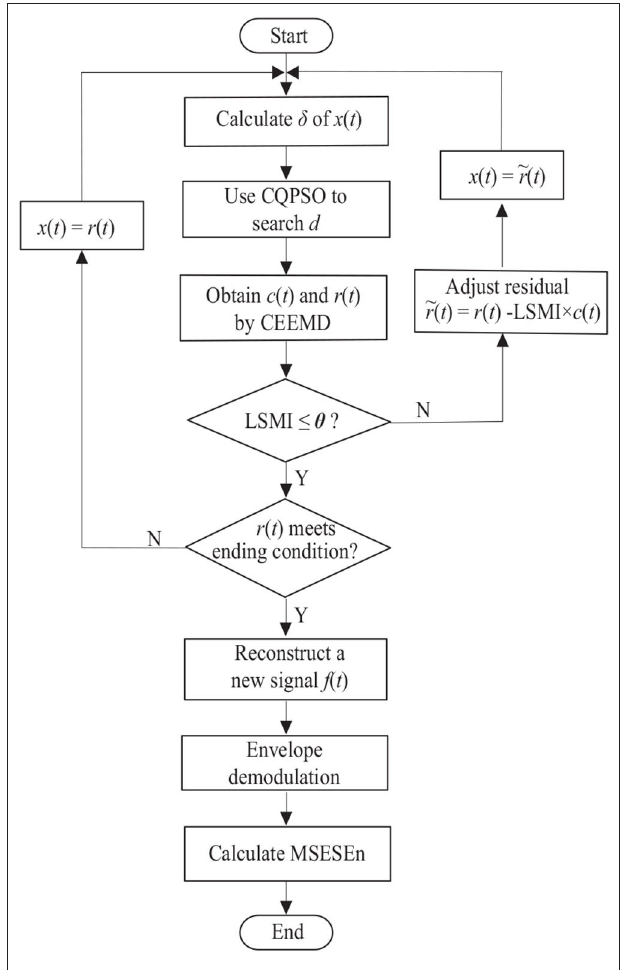
FIGURE 2 | Flow chart of sEMG signal